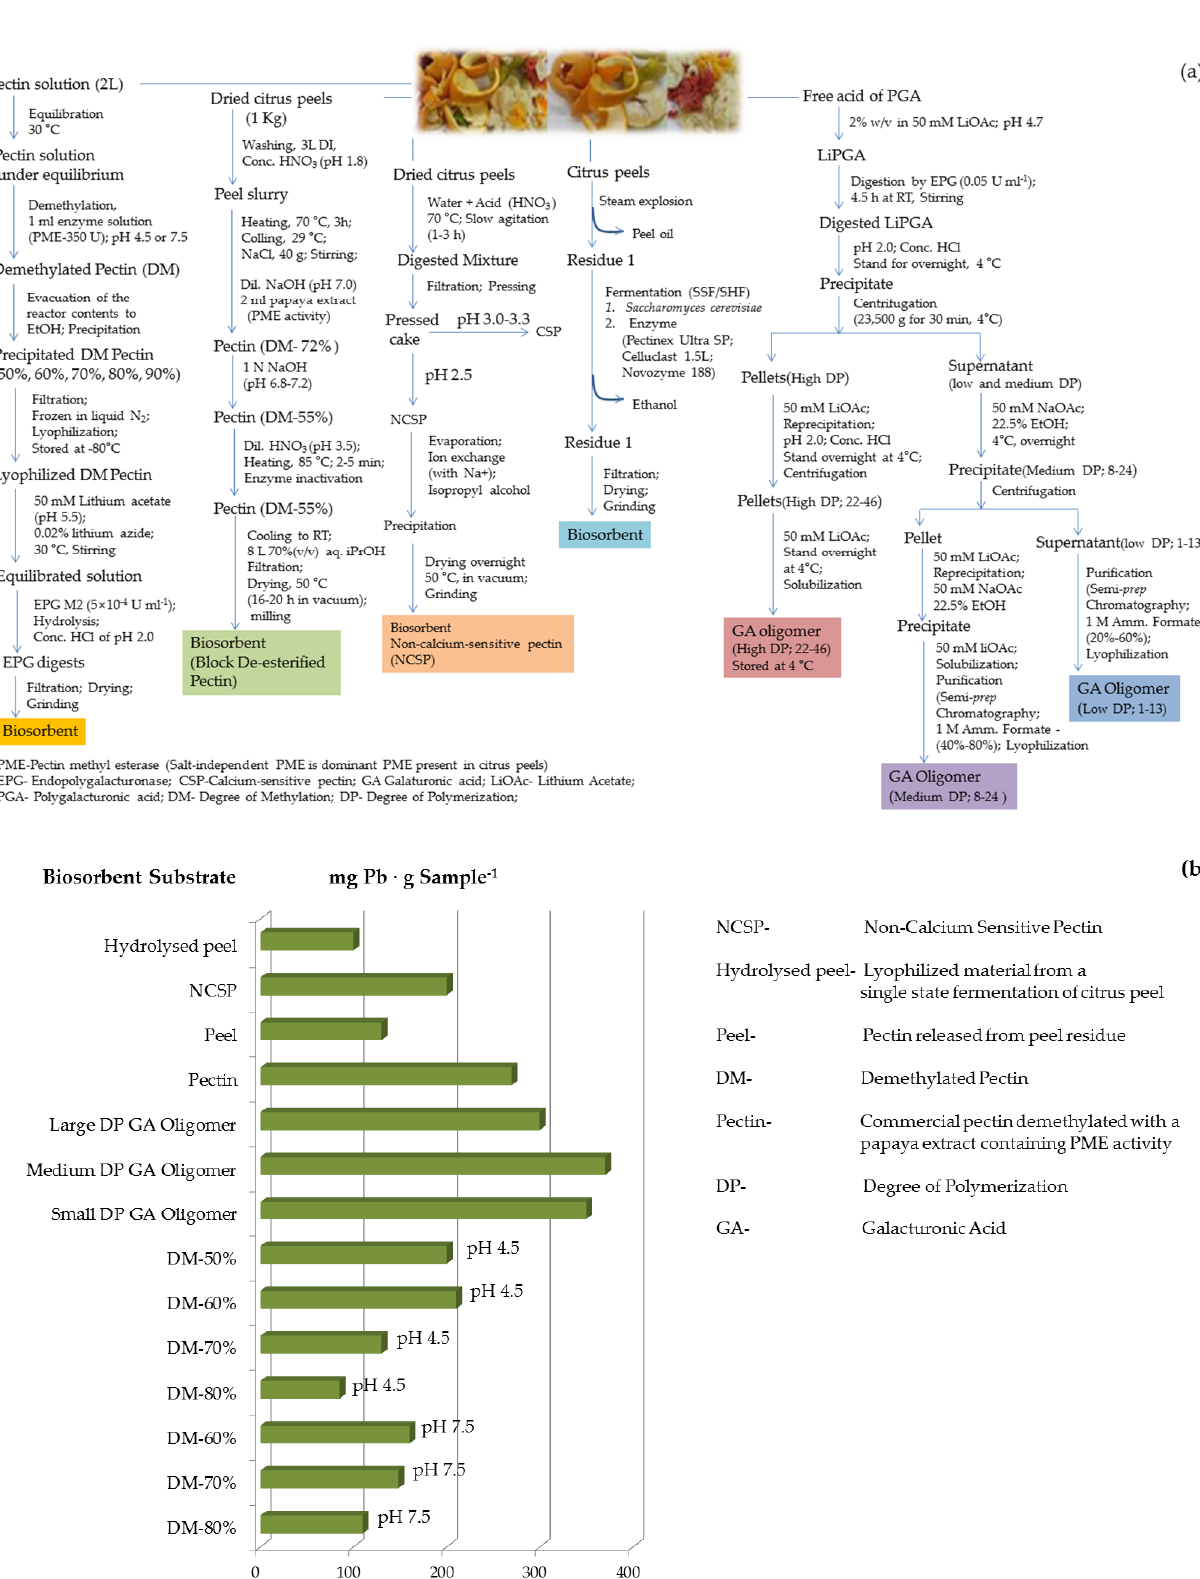
Figure 7. ( a ) Preparation of bio-sorbent from biochemical treatment of citrus peel waste. ( b ) Bio-sorption capacities of different bio-sorbent substrates prepared in ( a ). Adapted from the information provided in References [89–91].